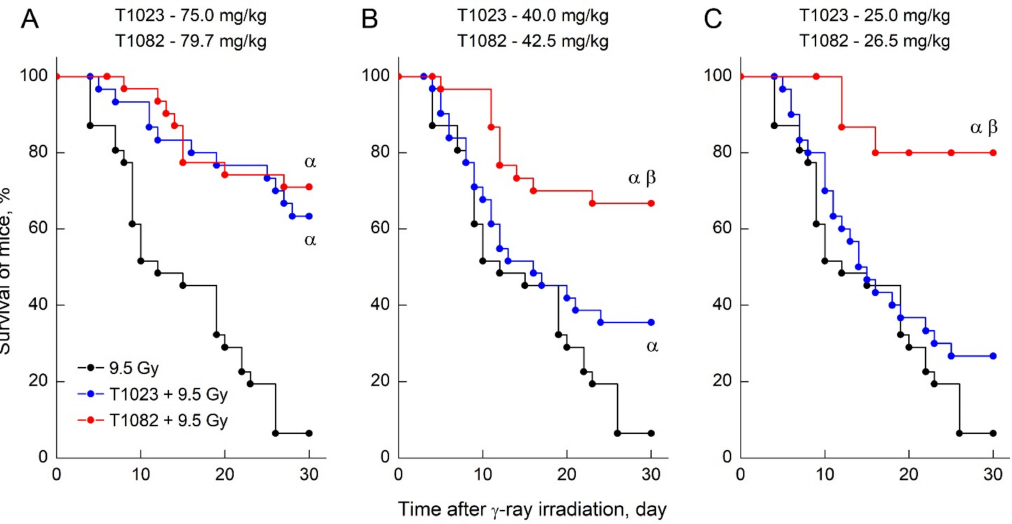
Figure 3. The effect of compounds T1023 and T1082 (single, i.p., 30 min before irradiation) in equimolar doses corresponding to 1/4 LD 10 ( A ), 1/8 LD 10 ( B ), and 1/12 LD 10 ( C ) on the survival of F 1 (CBA × C 57 BL 6j ) mice after 9.5 Gy γ -ray TBI. Data represent the combined results of two independent experiments ( n = 15–31 per group). Survival was plotted using the Kaplan–Meier method. α , significantly different vs. irradiated control mice (for T1023: p = 0.00008 and p = 0.03158; for T1082: p = 0.00006, p = 0.00022, and p = 0.00003, respectively). β , significantly different vs. T1023-treated mice ( p = 0.00808 and p = 0.00049,